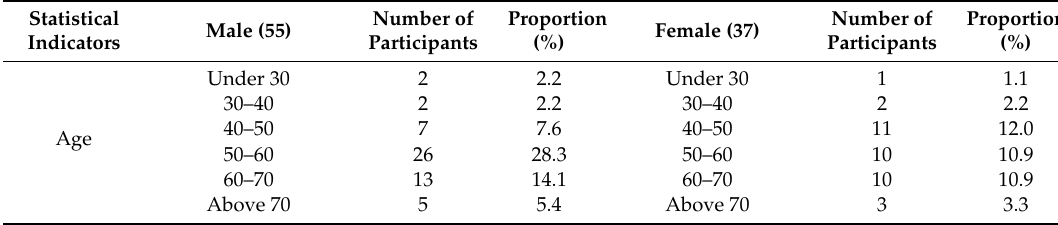
Table 1. Socioeconomic characteristics of the